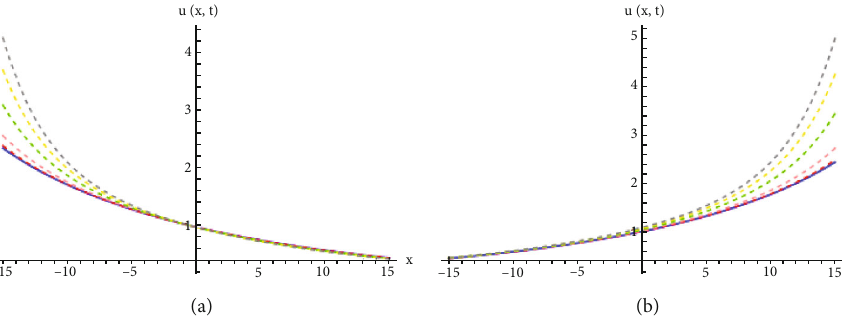
Figure 5: Surface plots of FCH4 model (40)-(62) at μ = 1 and λ = − 0 : 05 for diverse α : (a) α = 1 and (b) α = 0 : 75 . u (x, t)